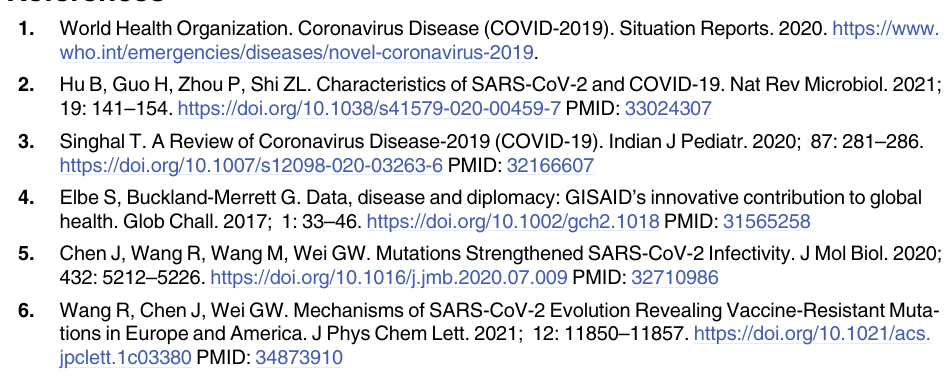
S1 Fig. Heatmap patterns. All 1169 heatmaps are presented along with 20-mer sequences.